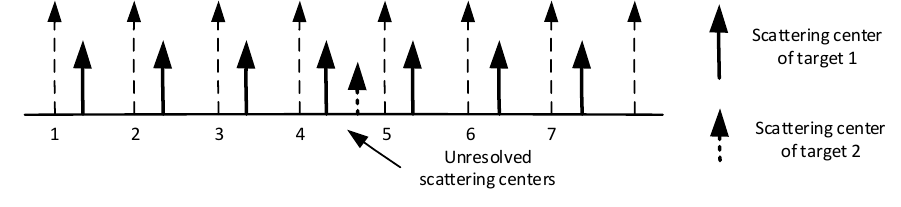
Figure 2. Position of scattering centers.